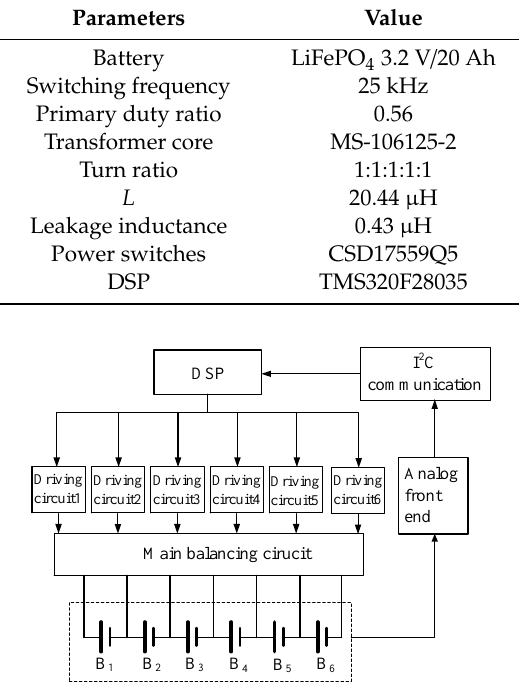
Figure 15. Block diagram of the balancing circuit.